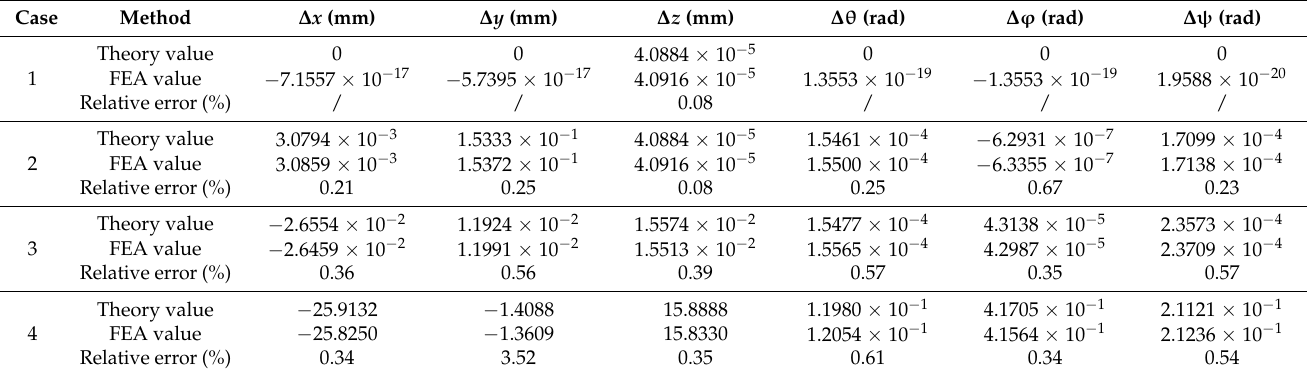
Table 3. Comparison results between the FEA method and theoretical method for the deformation in the four selected